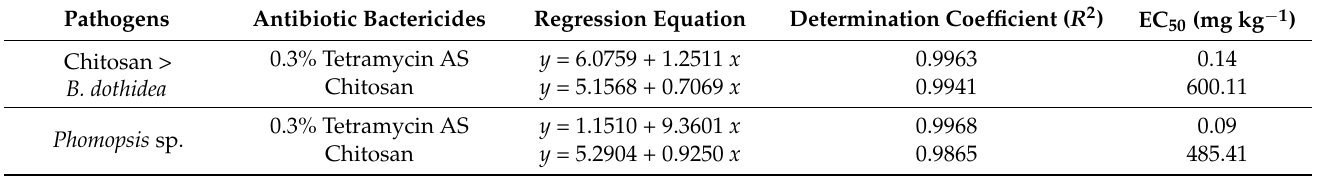
Table 1. Toxicities of tetramycin and chitosan against B. dothidea and Phomopsis sp .